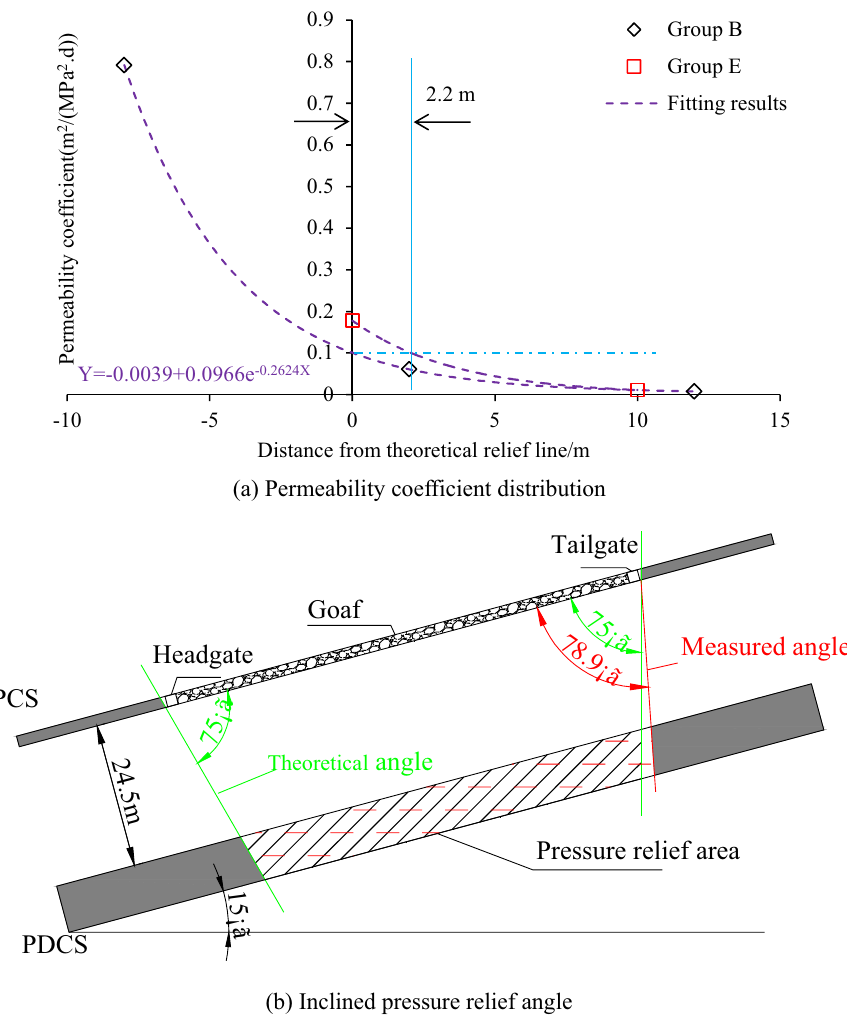
Figure 13. Inclined pressure relief angle and its